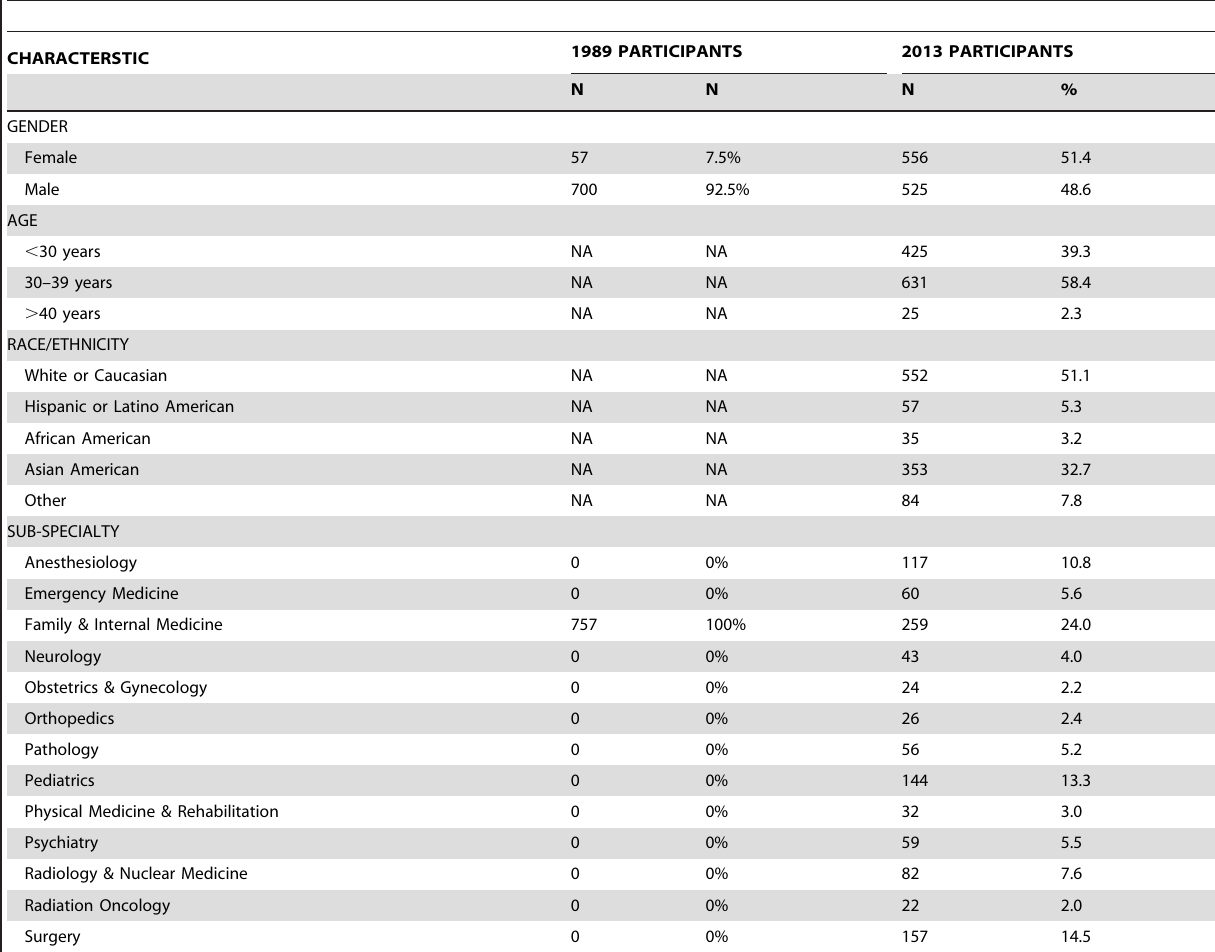
Table 1. Comparative demographics of